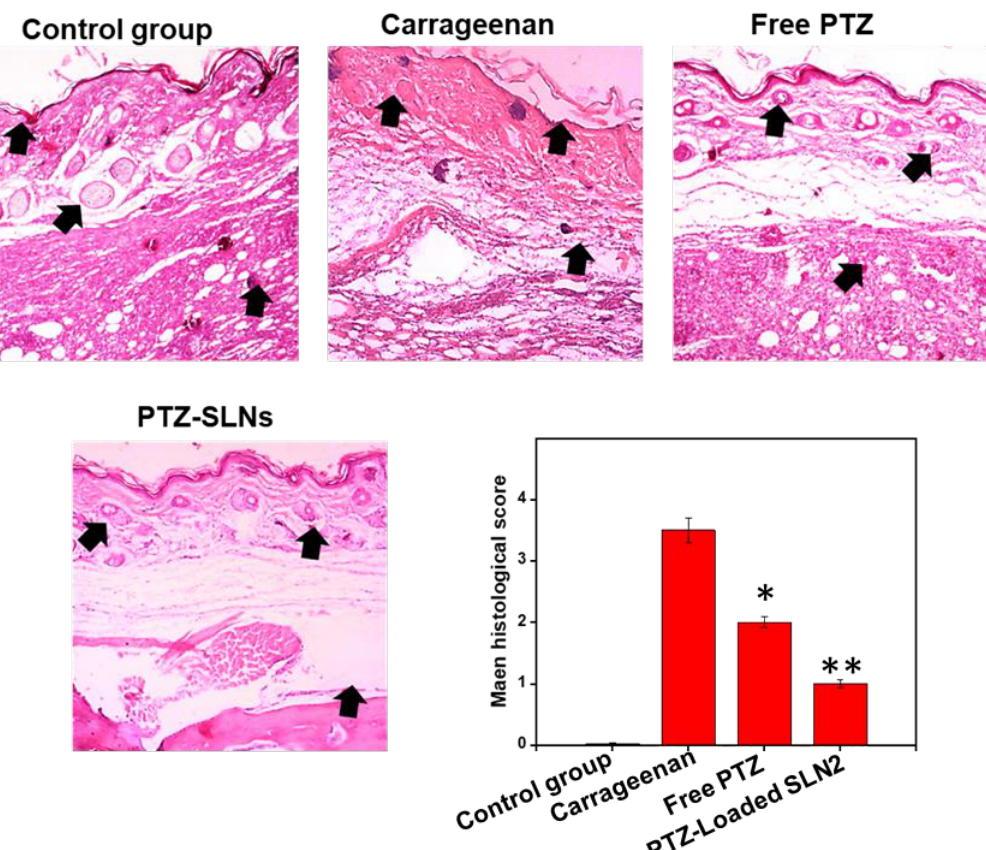
Figure 10. Effects of PTZ-SLN2 on the paw tissue architecture of Wistar rats (N = 20 rats, n = 5/group), following carrageenan-induced inflammatory pain. The samples were analyzed after H&E staining at the time point of 6 h after treatment. Control group 1 (1 × PBS, orally administrated), carrageenan group 2 (200 μL/paw of the 1% w / v solution, single injection), free PTZ group 3 (carrageenan 200 μL/ paw of the 1% w / v solution + free PTZ, orally administrated at 5 mg/kg), and PTZ-loaded SLN2 group 4 (carrageenan 200 μL/paw of the 1% w / v solution + PTZ-loaded SLN2, orally administrated at 5 mg/kg). The carrageenan was administered 30 min into the Groups 3 and 4 before the treatment (with free PTZ and PTZ-loaded SLN2, respectively). The carrageenan group strongly altered the paw tissue architecture, compared to the control group. These effects were all significantly reduced in the free PTZ and, to a better extent, PTZ-SLN2 groups, when compared to the carrageenan group. Data are expressed as mean ± SD ( n = 3). * p < 0.05 and ** p < 0.01 represent mild and moderate statistical significance, respectively, when compared to the carrageenan group.